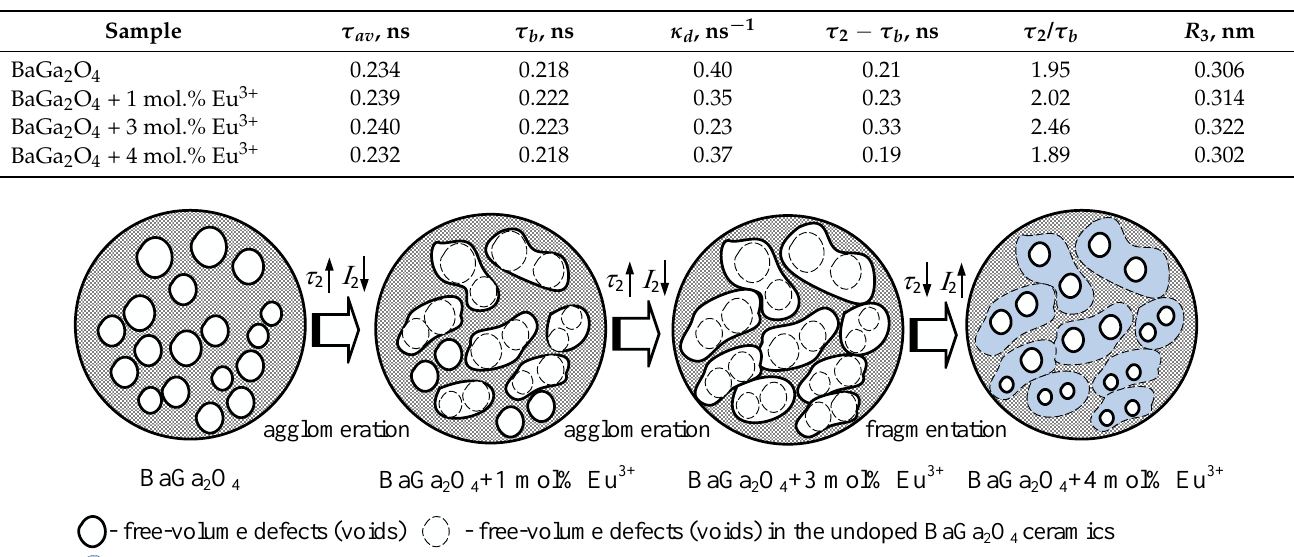
Figure 4. Diagram explaining the evolution of defect-related voids in BaGa 2 O 4 ceramics caused by Eu 3+ doping.